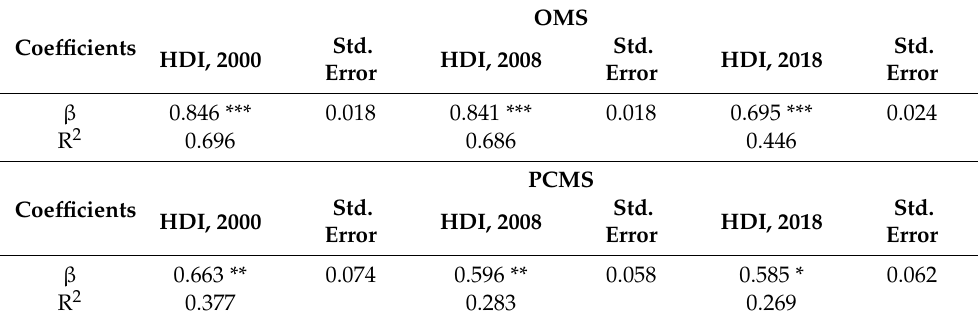
Table 6. Binary regression results between residential energy use per capita and HDI (2 groups of EU member states based on East–West division).